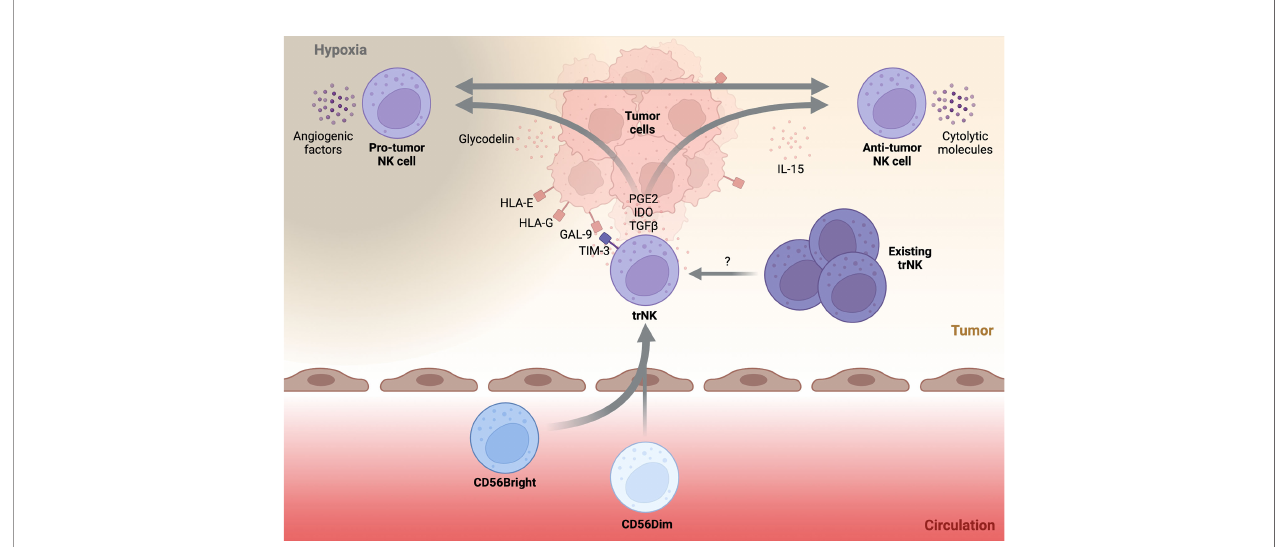
FIGURE 2 | Schematic highlighting possible drivers and trajectories of tumor-in fi ltrating NK cells.A simpli fi ed schematic of the potential drivers and phenotypes of tumor-in fi ltrating NK cells. Circulatory NK cells (below) invade the tumor tissue (above) and acquire a tissue-resident NK (trNK) phenotype. Immunomodulatory factors within the tumor microenvironment such as, PGE2, IDO, and TGF b help to solidify the trNK phenotype. Pre-existing trNK cells may also in fi ltrate the developing tumor and be directed towards various tumor-in fi ltrating NK phenotypes. Direct cell-cell contact between trNK cells and tumor tissue through non-classical HLA recognition or GAL-9-TIM-3 interaction may push trNK cells towards a pro-tumor phenotype. Additionally, secreted factors such as glycodelin or tissue hypoxia may promote pro-angiogenic properties of trNK cells. Alternatively, trNK cells may be driven towards an anti-tumor phenotype by stimulatory molecules such as IL-15. It is unknown if plasticity between the two trNK fates is possible and what factors drive this conversion. Transforming growth factor beta (TGF b ), Galectin-9 (GAL-9), Prostaglandin E2 (PGE2), Indoleamine-2,3-Dioxygenase